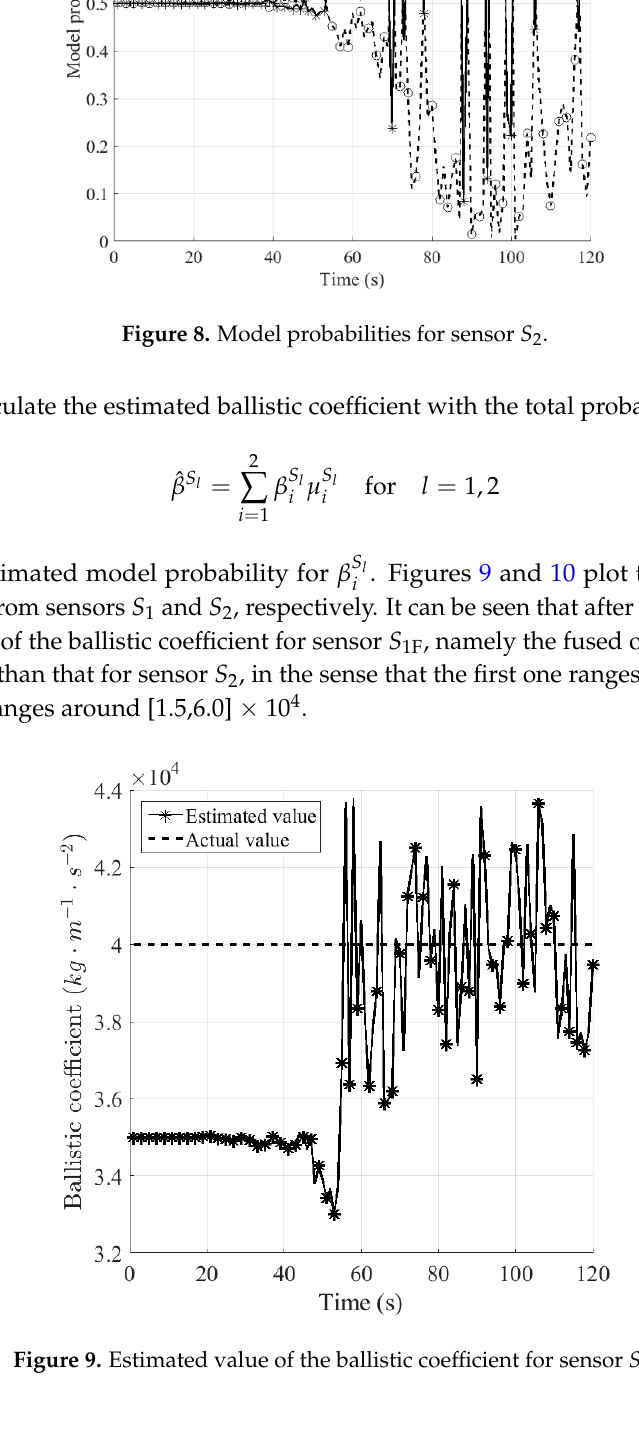
Figure 7. Model probabilities for sensor S 1 .